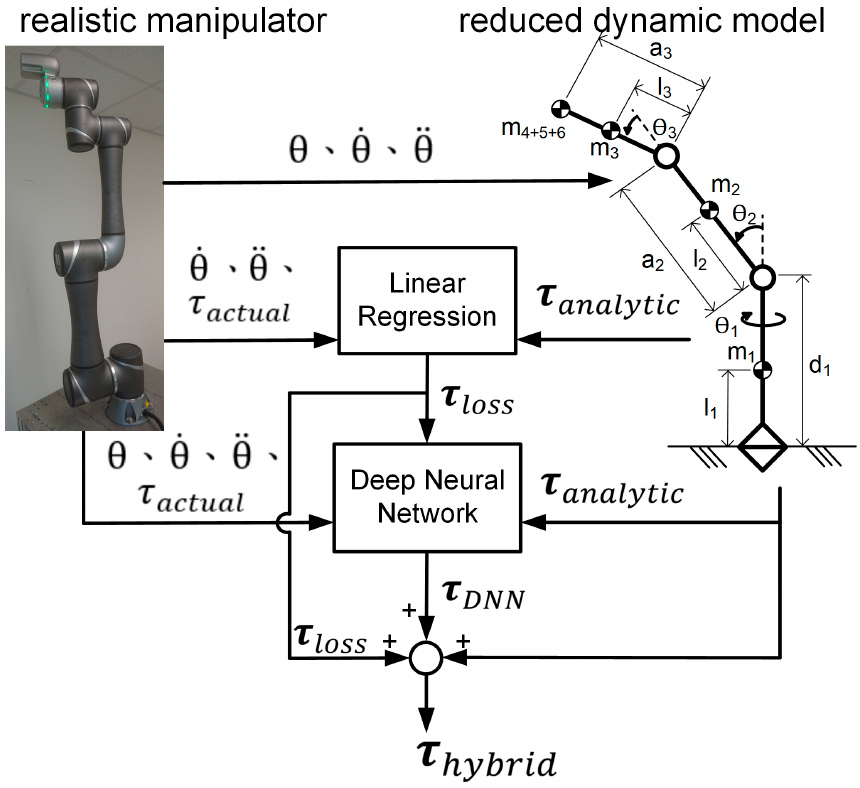
Figure 2. The overall construction framework of the hybrid dynamic model.